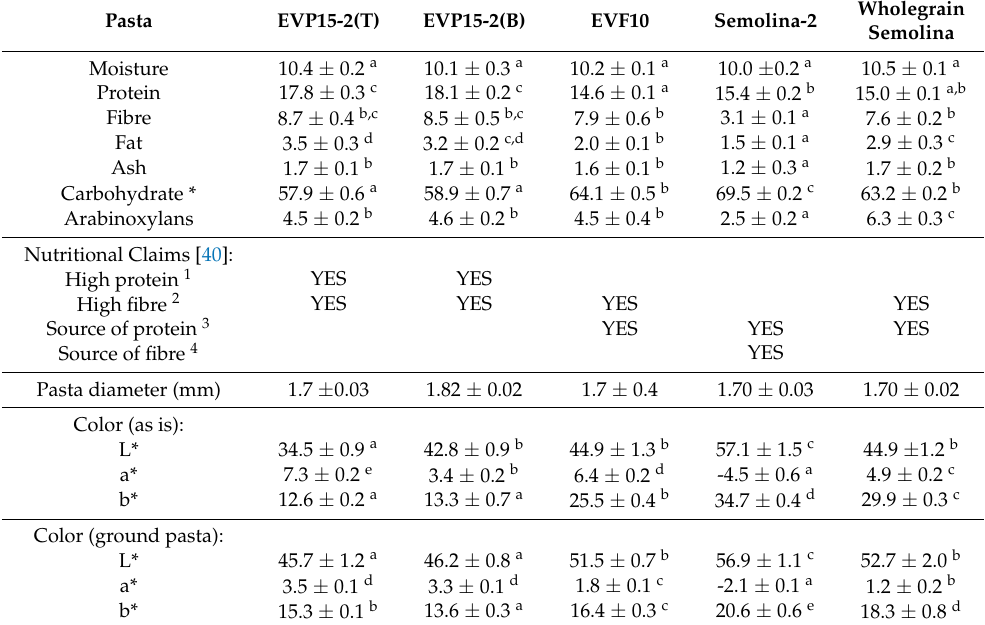
Table 5. Proximate composition (g/100 g fw), achievement of nutritional claims diameter and color characteristics of different pasta. Different letters in rows indicate statistically significant differences ( p <